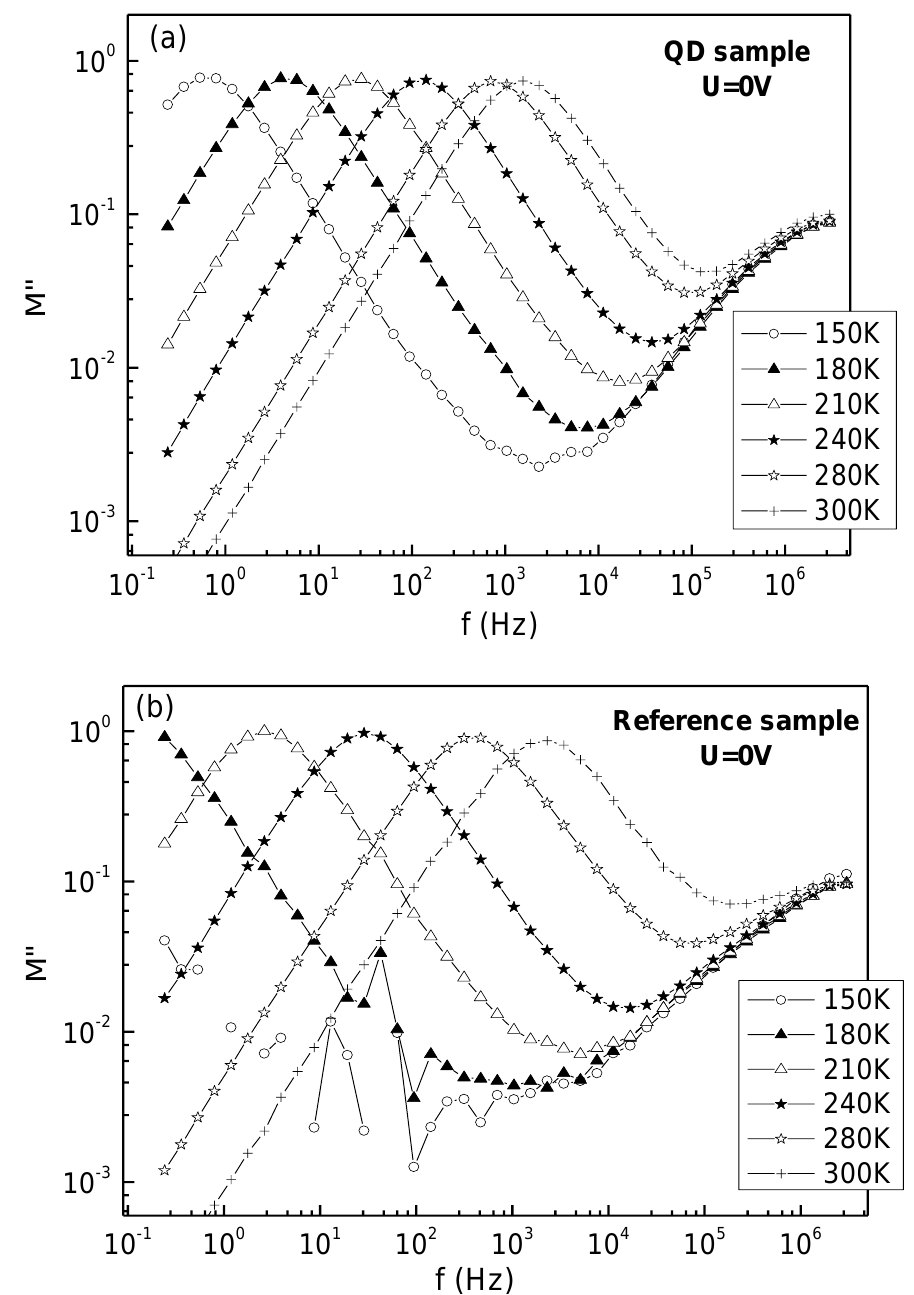
Figure 5. Double-logarithmic imaginary part of electric modulus vs. frequency plots measured at different temperatures for the quantum dot ( a ) and reference samples ( b ).